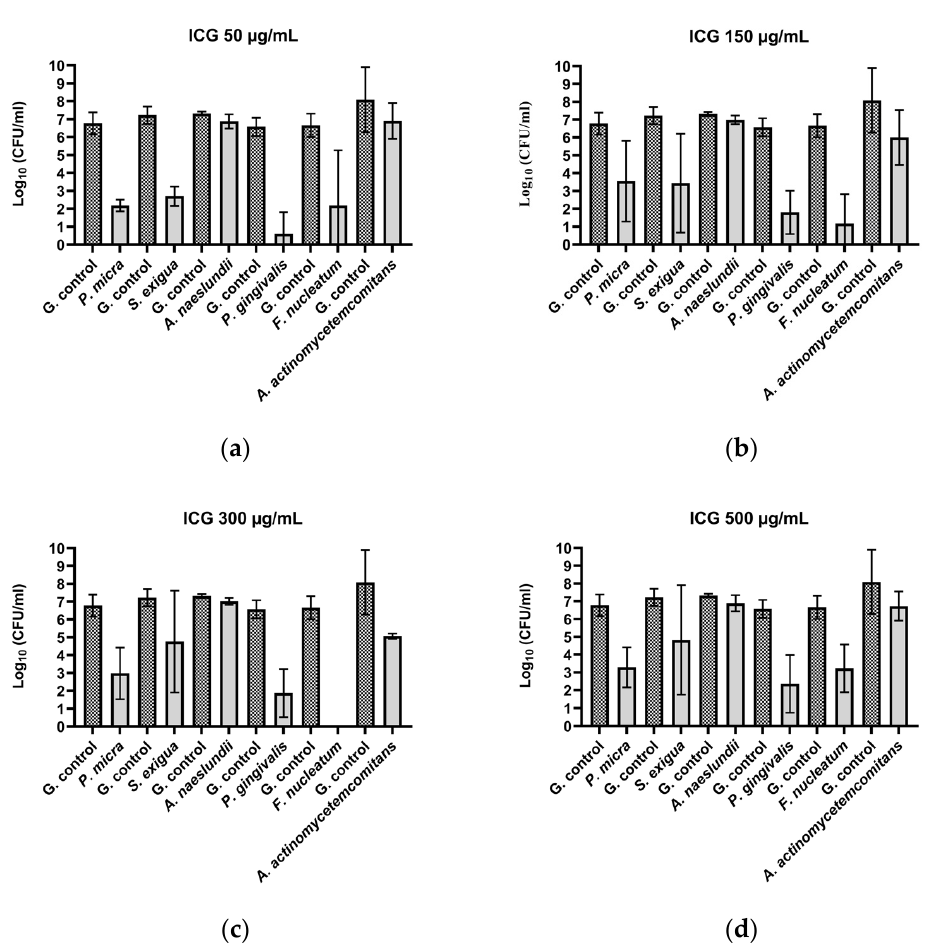
Figure 2. Photodynamic efficacy of ICG in combination with Vis + wIRA against periodontal bacteria. ICG was tested at concentrations of ( a ) 50 µ g/mL, ( b ) 150 µ g/mL, ( c ) 300 µ g/mL, and ( d ) 500 µ g/mL. The CFU numbers are given on a log 10 scale per milliliter (log 10